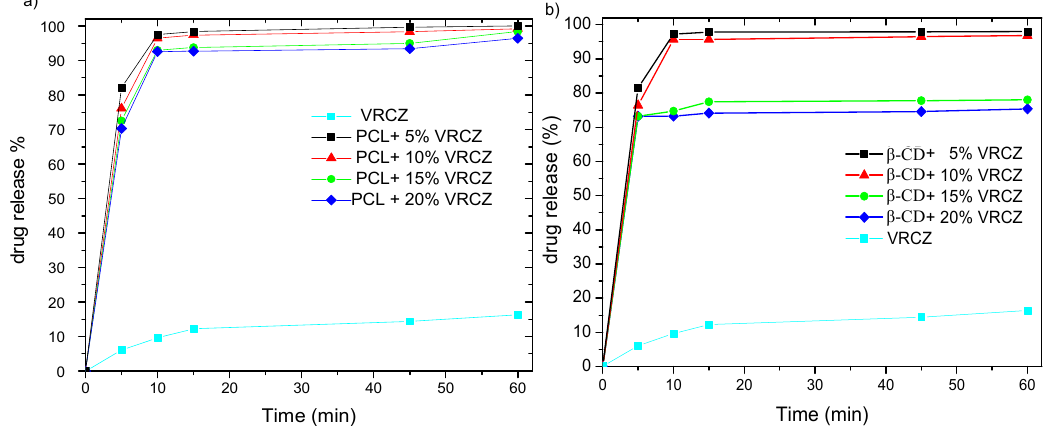
Figure 9. ( a ) In vitro release studies of PCL fibers containing VRCZ and ( b ) in vitro release studies of VRCZ inclusion complexes. Table 2. Water uptake and degraded morphology of the PCL/VRCZ fibers during dissolution for 1h.